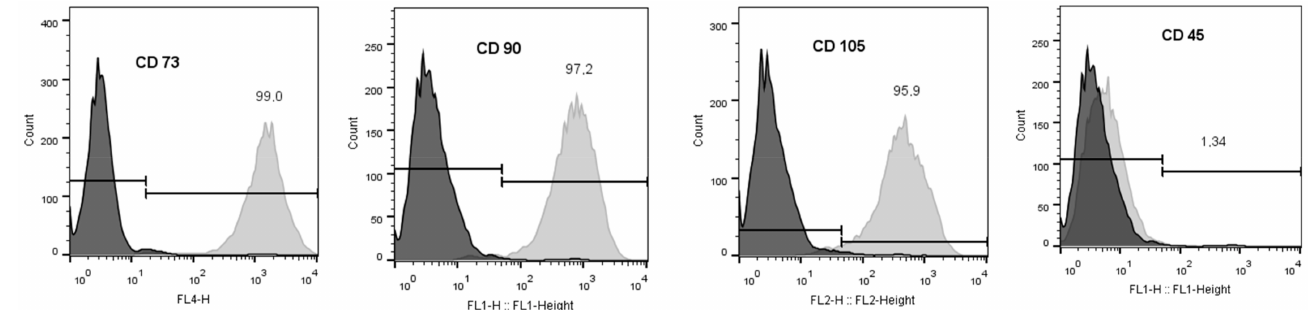
Figure 2. Surface markers expression in BM-MSCs. BM-MSCs were confirmed by flow cytometry analysis as positive for CD73 (99.00%), CD90 (97.2%), CD105 (95.9%), and negative for CD45